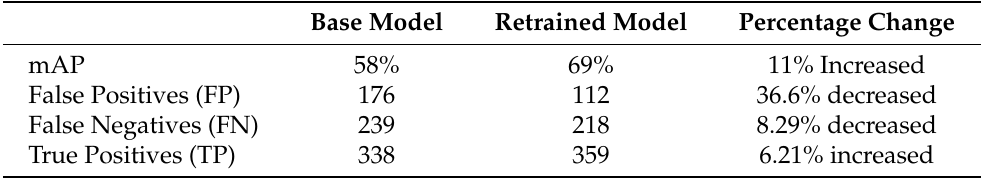
Table 7. The performance comparison of base model and retrained model on field collected test